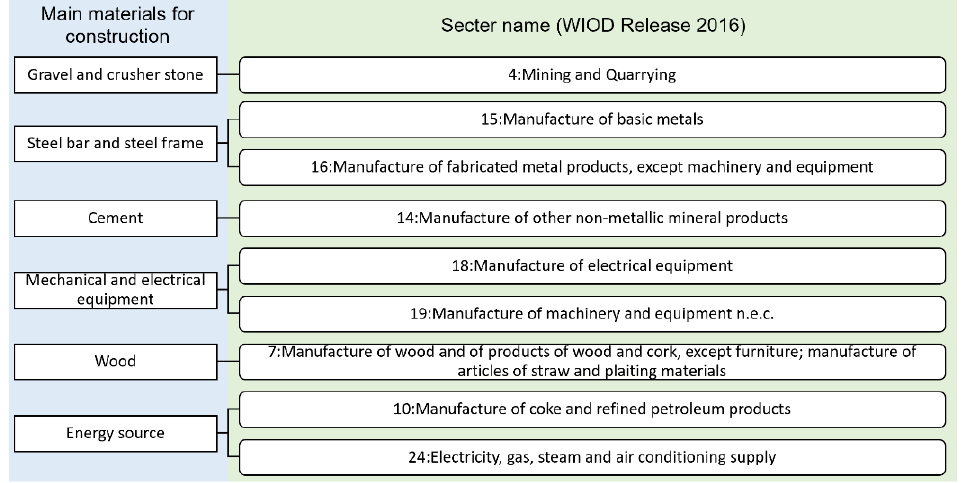
Figure 7. CO 2 emissions by sectors comprising construction EGs. 3.5. Relationship with Cement Production In the previous section, the sector of cement production was identified as having a large impact on construction EG. Figure 8 shows the relationship between CO 2 emissions by cement production and construction EG in each country, according to statistical data on carbon emissions from the Carbon Dioxide Information Analysis Center (CDIAC) [18]. From Figure 8, since the approximate curve is an upward-sloping equation, a strong positive correlation between cement production and construction EGs was considered. It was found that CO 2 emissions from cement production account for approximately 31% of construction EG in many countries.